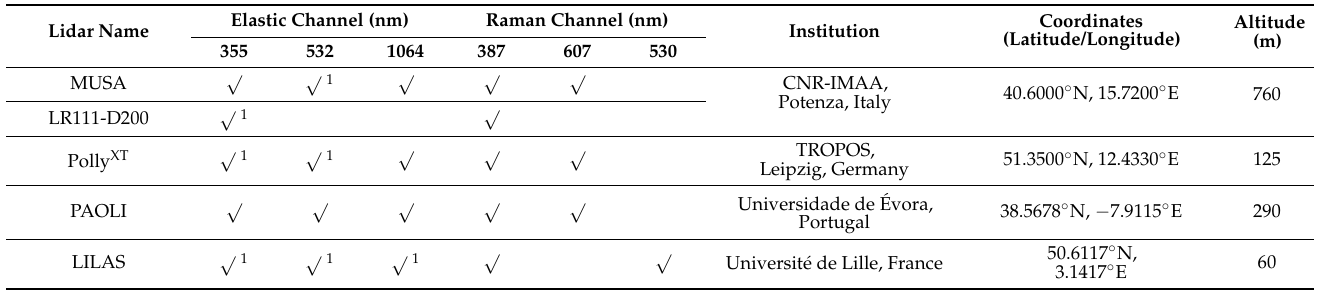
Table 1. Basic information (including the availability of each optical channel) of EARLINET Lidar Systems operated by CNR-IMAA (Potenza, Italy), TROPOS (Leipzig, Germany), the University of É vora (Evora Portugal), and the University of Lille (Lille,